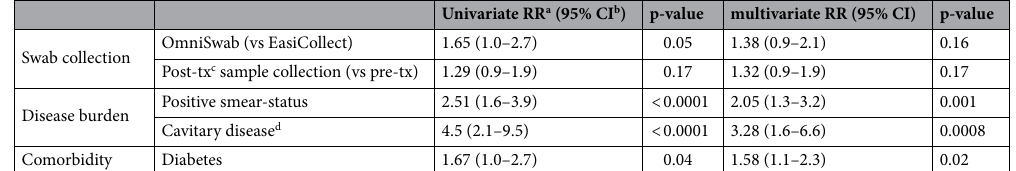
Table 4. Factors associated with Mycobacterium tuberculosis detection in 350 buccal samples. a RR risk ratio. b CI confidence interval. c tx treatment. d The univariate model for cavitary disease and multivariate model includes a missing indicator for the six people (18 samples) for whom X-ray was